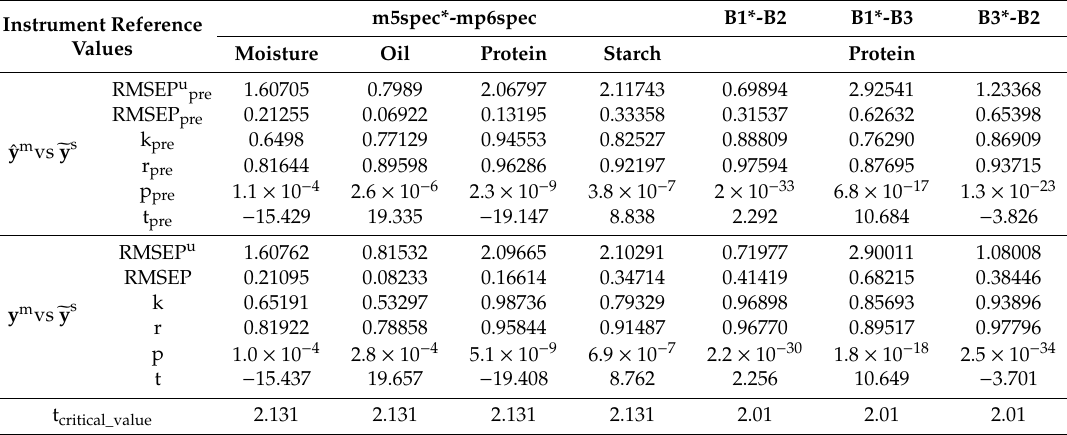
Table 2. Summary of the relevant results between uncorrected and CTAI corrected. Instrument Reference Values